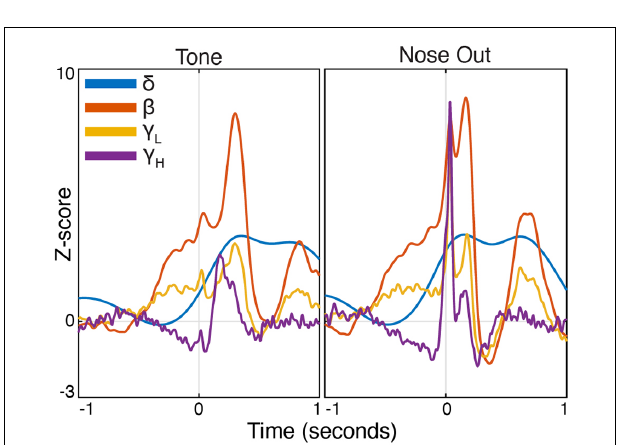
FIGURE 3 | Peri-event FP power modulation in selected frequency bands at Tone and Nose-Out. Mean power modulation for all 30 sessions ( n = 5 rats) in the delta, beta, low, and high gamma bands are all more tightly locked to Nose Out than Tone, suggesting a motor rather than sensory-related